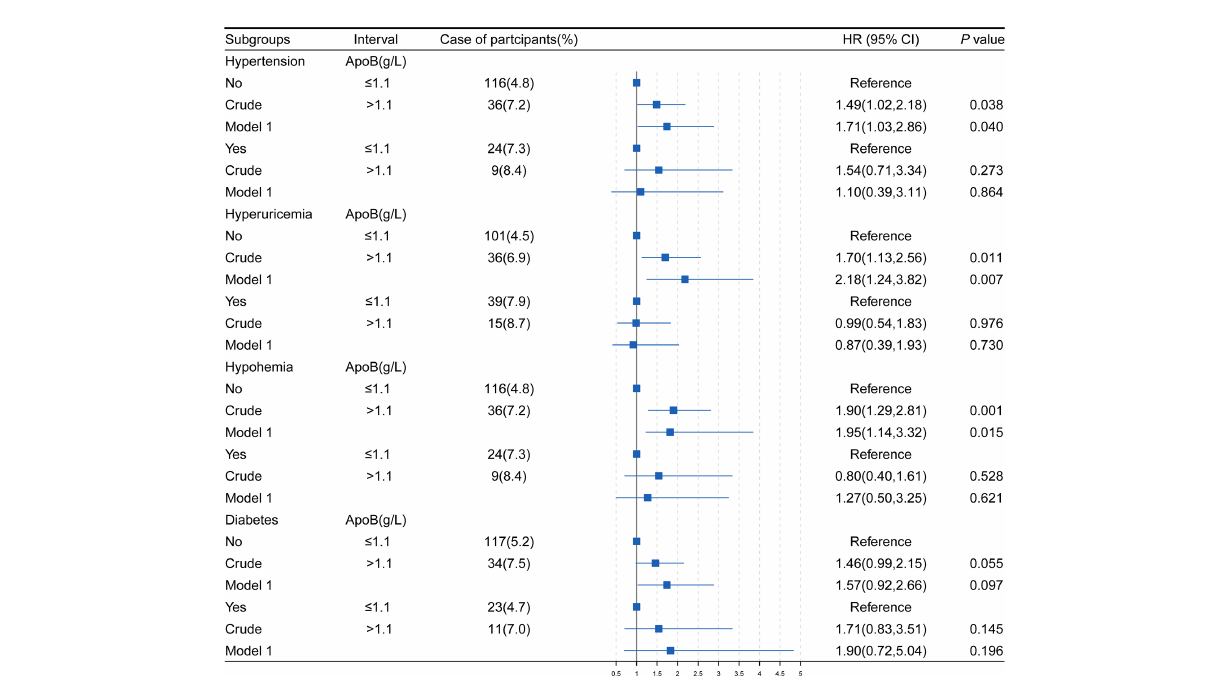
FIGURE 2 The association of ApoB and the development of CKD in study subjects strati fl ed by hypertension, hyperuricemia, hypohemia, diabetes. HR, hazard ratio; CI, con fi dence interval; BMI, body mass index; HGB, hemoglobin; ApoB, apolipoprotein B; TG, triglyceride; TC, total cholesterol; WBC, white blood cell. Model1, adjusted for age, sex, BMI, hypertension, diabetes, hyperuricemia, HGB, TG, TC, WBC, alcohol use and smoke status. * P values were calculated based on Cox